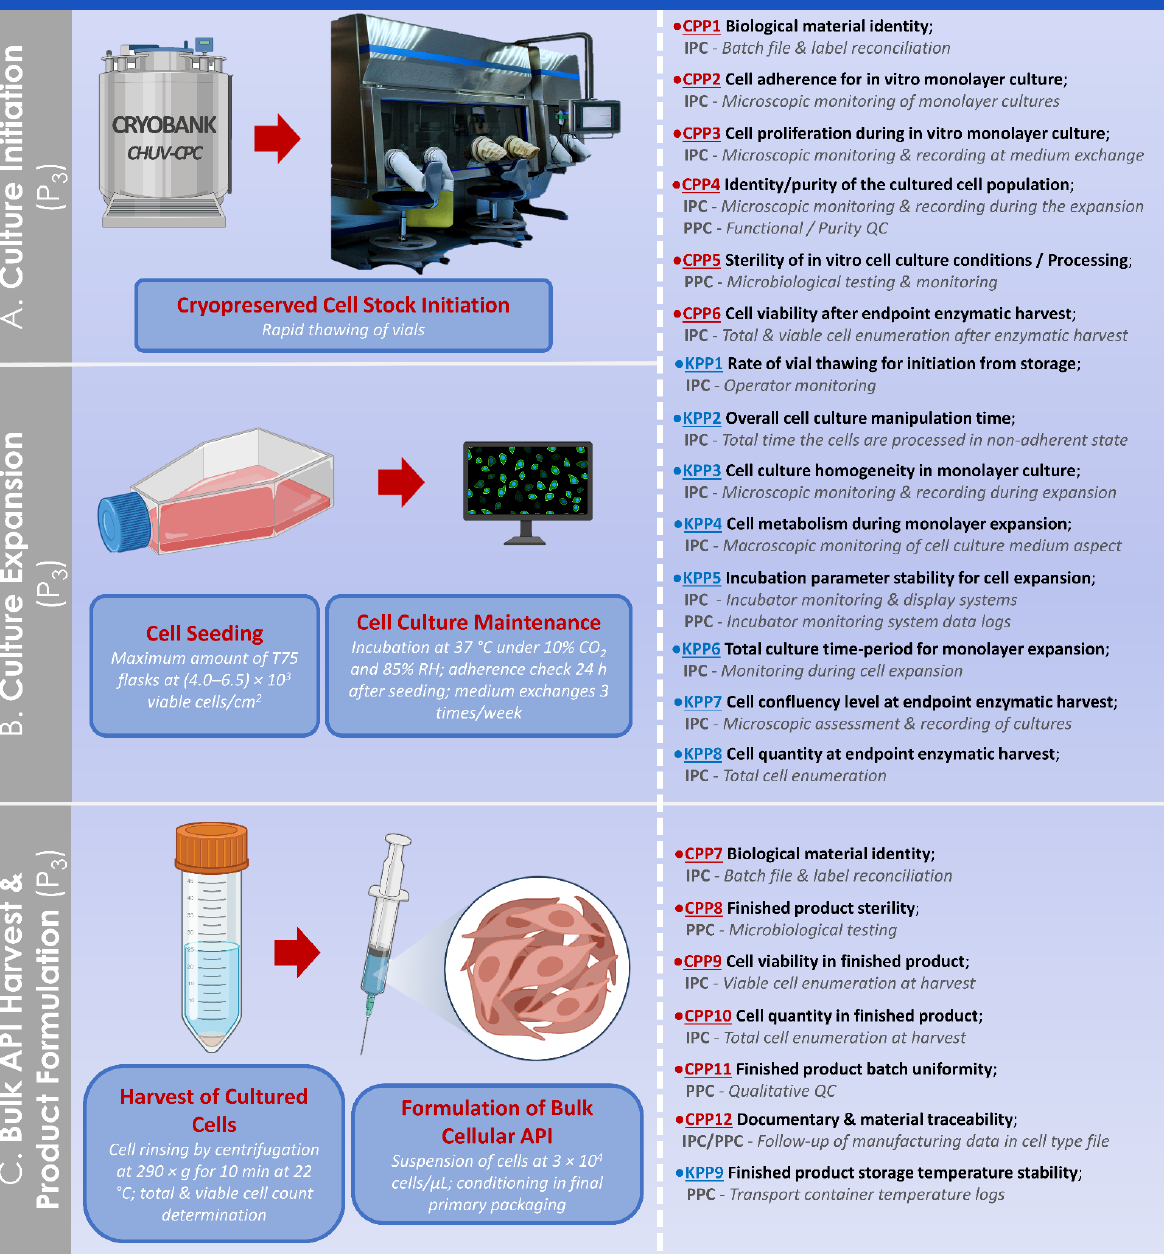
Figure 10. Standardized parametric and controlled process overview for the obtention of the finished product from the MCB or the WCB. ( A ) Culture initiation of MCB/WCB materials for the final in vitro cell expansion. © CHUV-CPC. ( B ) Single in vitro cell expansion. ( C ) Harvest and formulation of the obtained cells for the obtention of the finished product. The established CPPs, KPPs, IPCs, and PPCs are further defined in the supplementary document – Process Parameters: Table SPP4. API, active pharmaceutical ingredient; CHUV, centre hospitalier universitaire vaudois; CPC, cell production center; CPP, critical process parameter; HAC, human articular chondrocytes; IPC, in-process control; KPP, key process parameter; MCB, master cell bank; PPC, post-process control; QC, quality control; RH, relative humidity; WCB, working cell